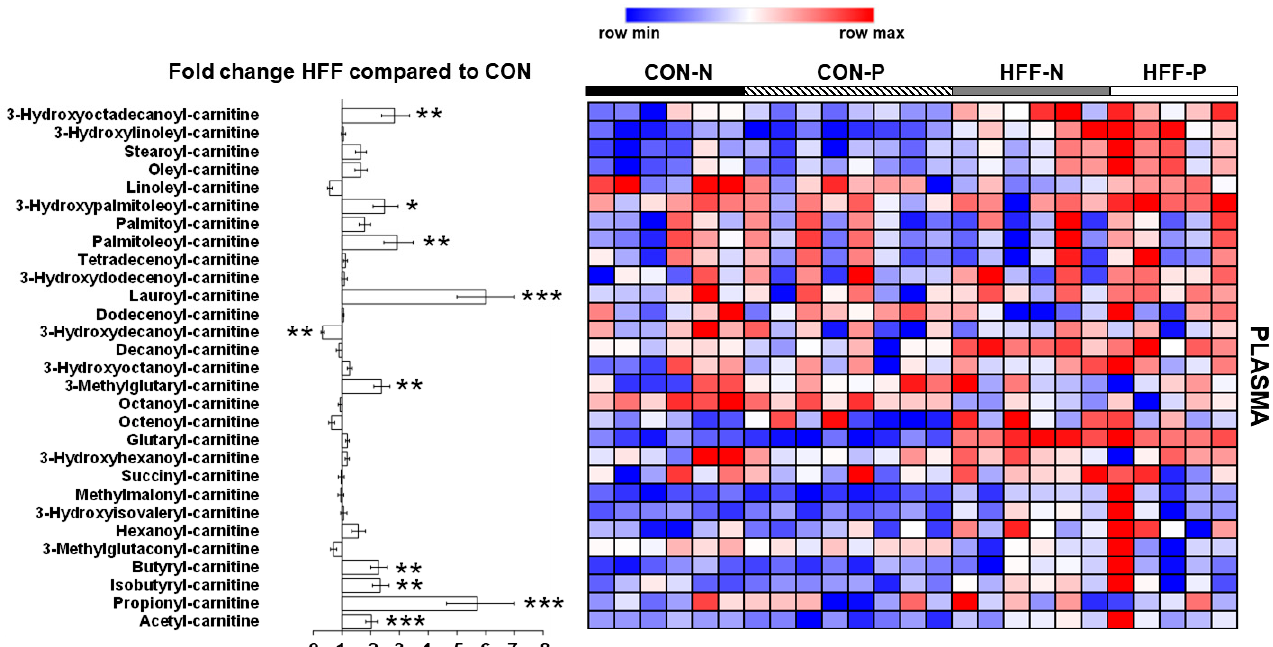
Figure 4. Effect of high-fructose, high-fat diet (HFF) on plasma metabolites related to dysregulated skeletal muscle composition and metabolism in juvenile Iberian pigs. Levels of several acylcarnitines are increased in plasma of HFF-fed versus CON-fed pigs, indicating dysregulated lipid metabolism. CON—control; CON-N—control diet without probiotic supplementation; CON-P—control diet with probiotic supplementation; HFF-N—high-fructose, high-fat diet without probiotic supplementation; HFF—P-high-fructose, high-fat diet with probiotic supplementation. Statistical significance between groups is indicated by * ( p ≤ 0.05), ** ( p ≤ 0.01), and *** ( p ≤ 0.001).